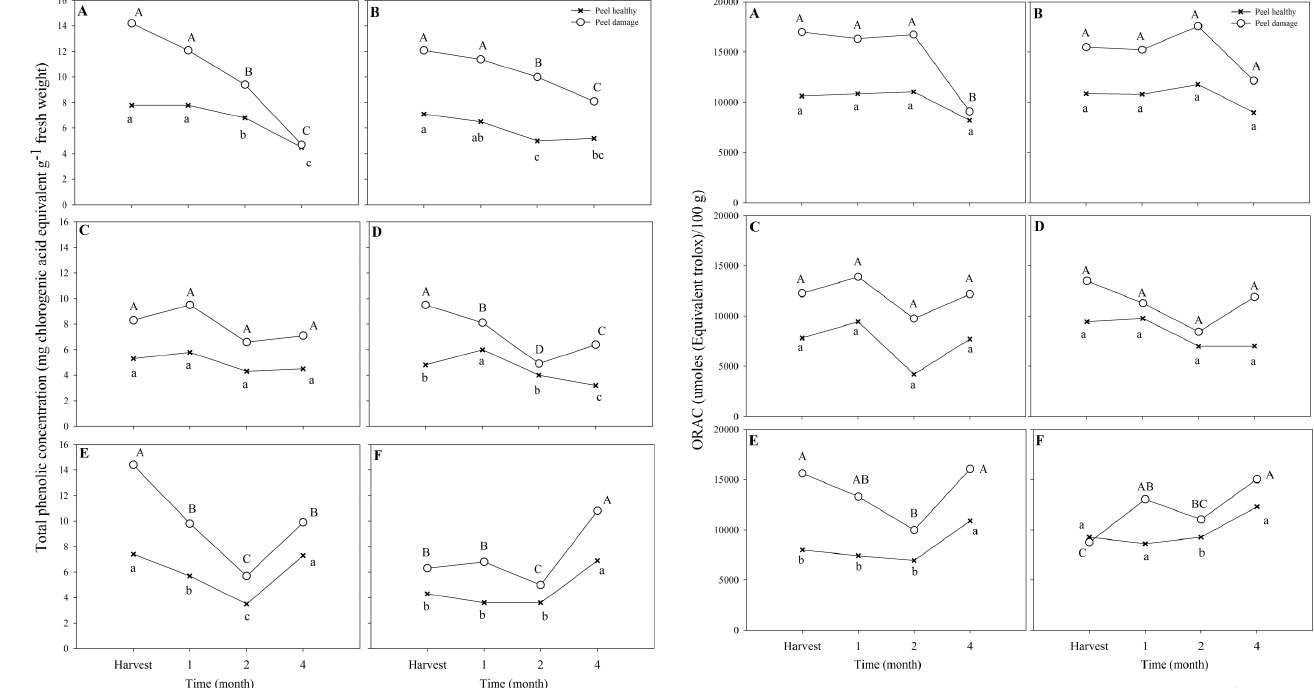
Phenolic compound content decreased in the peel of cv. Brookfield ® (Fig. 2) during storage. ANOVA were made during the time, from harvest to 4 months of storage. Initially CO sunburn-damaged fruit had higher phenol content, while at the end of the storage period the highest phenol content was found in OO fruit. ORAC was observed to have increased at two months of storage in both OO and CO Gran- ny Smith and Fuji apples, although the increased was only significant